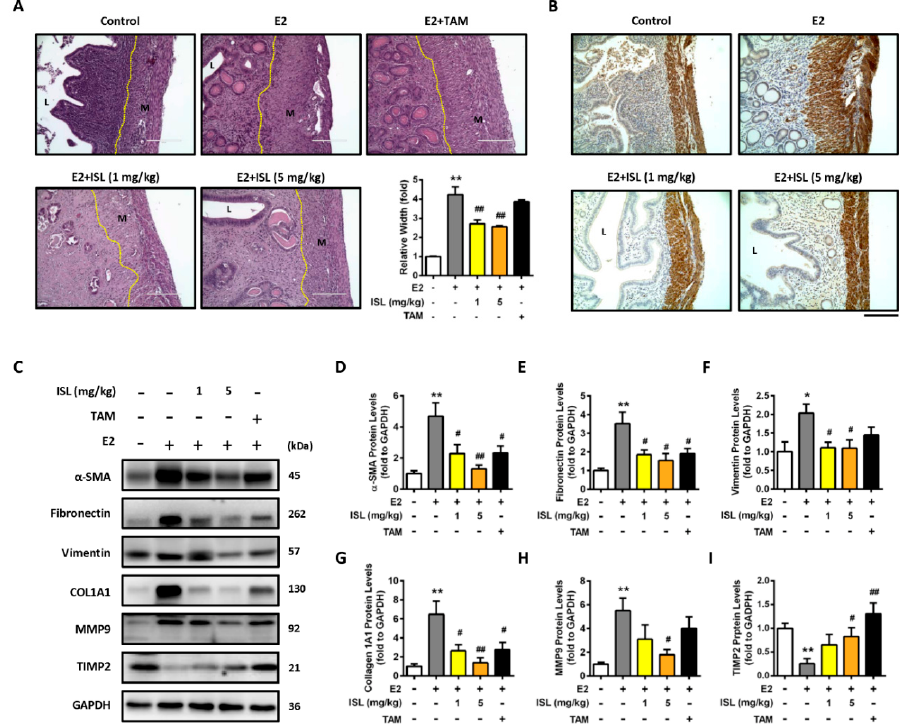
Figure 8. ISL suppressed E2-induced uterine myometrium hyperproliferation and extracellular matrix-associated protein expression. ( A ) To three to five micrometer cross-sections of uterine tissues, hematoxylin and eosin (H&E) staining was performed, and the thick of myometrium layer was evaluated (magnification 200×; Scale bar = 200 μ m). ( B ) The expression of smooth muscle target protein was analyzed using immunohistochemical staining of uterine sections with anti-alpha-smooth muscle actin ( α -SMC) antibody magnification 200×; Scale bar = 200 μ m). ( C ) Uterine tissues were lysed, and extracellular matrix associated proteins were analyzed by Western blot; ( D – I ) each target protein was normalized to GAPDH expression. Data are represented as means ± SEM ( n = 5 each group). * p < 0.05, ** p < 0.01 compared with the control group. # p < 0.05, ## p < 0.01 compared with the E2-treated group. L, luminal space; M,